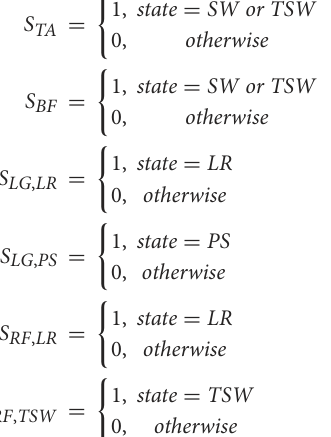
Figure 3. The generation of electrical stimulation patterns